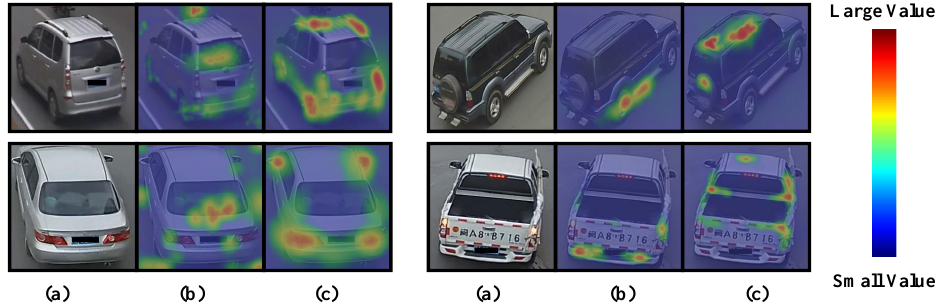
Figure 7. Comparisons of visualization results between baseline model and APANet. ( a ) Original images; ( b ) baseline; ( c )